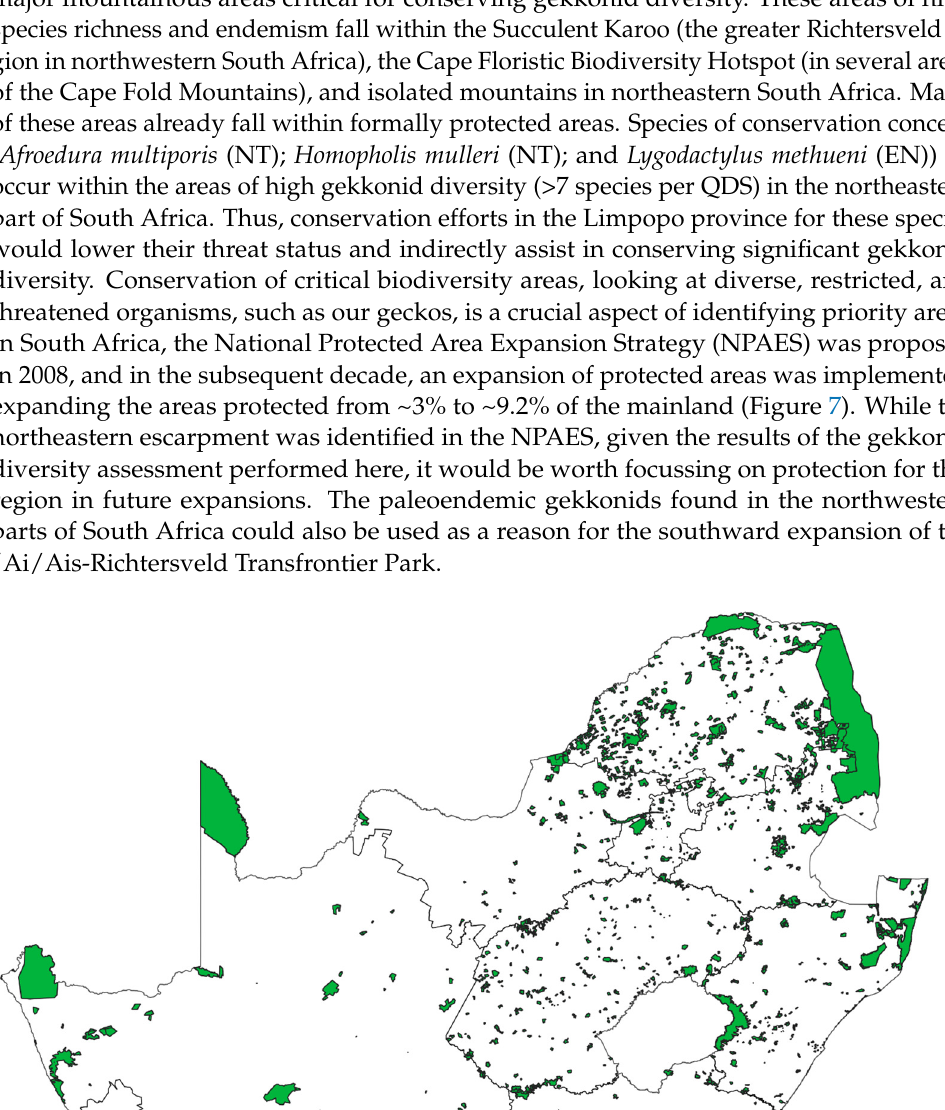
Table of gekkonid species found in the Southern African countries, and the genetic sequences obtained from Genbank used in the phylogenetic tree production. All gecko species found in Southern Africa are listed in this table, and those species that did not have genetic information for the three gene regions are indicated by “no seq” or